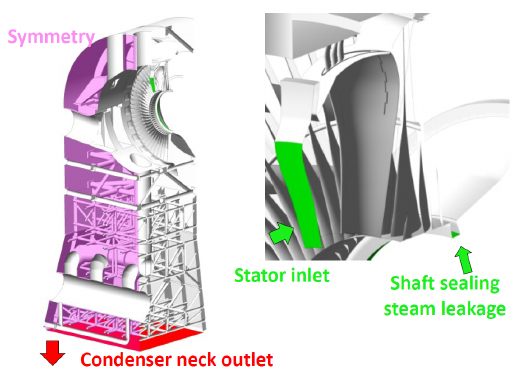
Figure 4. Calculated geometry.